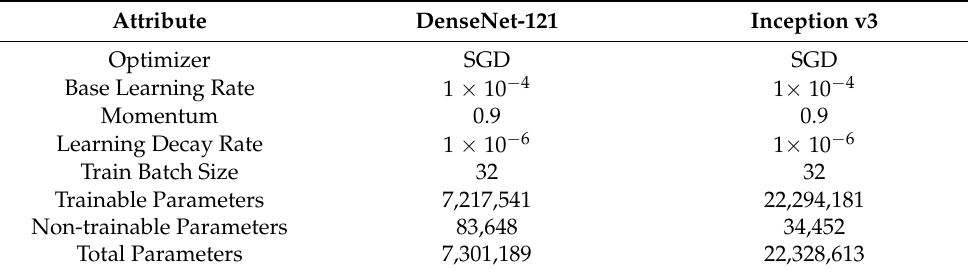
Table 2. Inception v3 and DenseNet-121 training parameter